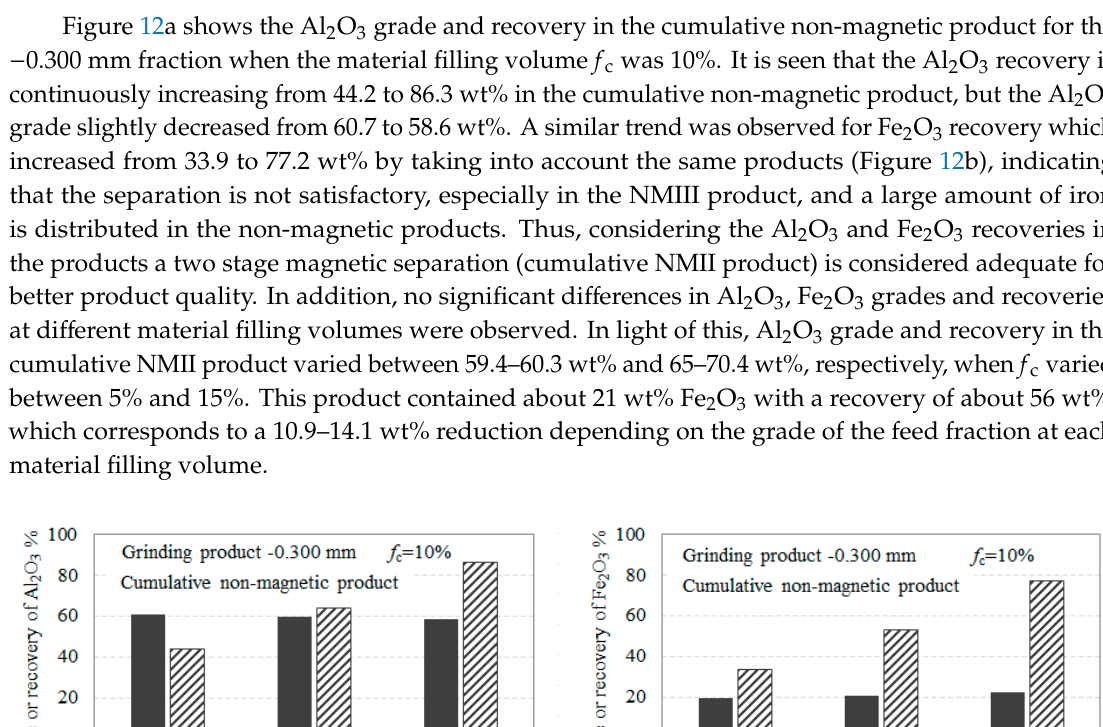
Figure 11. Effect of material filling volume f c on ( a ) Al 2 O 3 grade and recovery and ( b ) Fe 2 O 3 grade and recovery in the NMII product when the 0.300 – 1.18 mm fraction was subjected to magnetic separation.